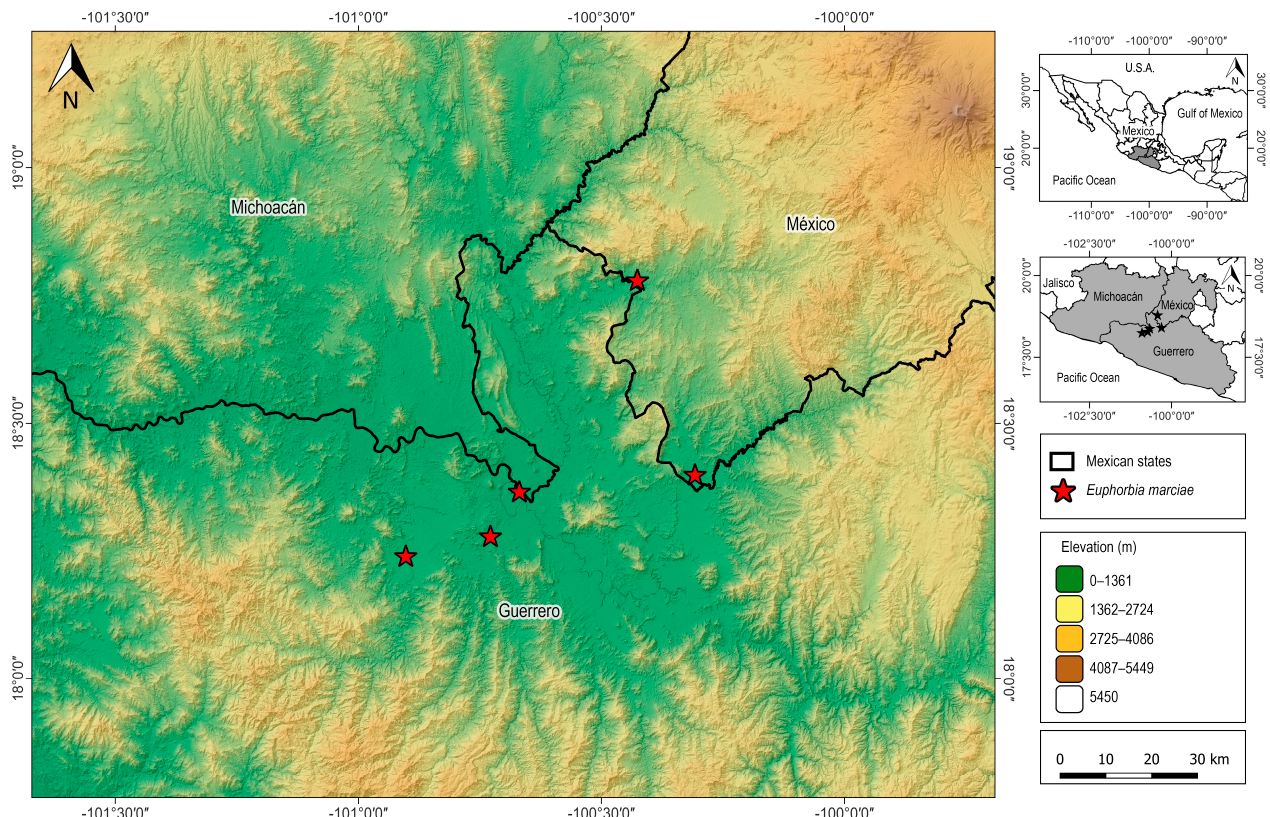
Figure 3. Distribution of Euphorbia marciae .